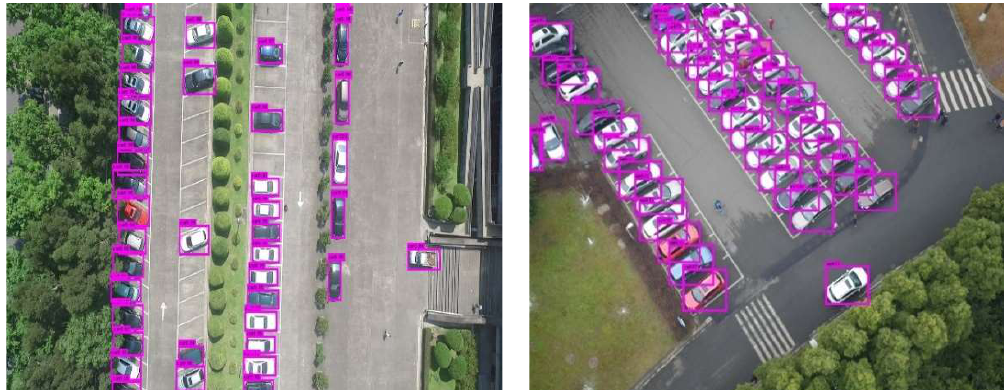
Figure 7. Detection examples of the improved YOLOv3 network.